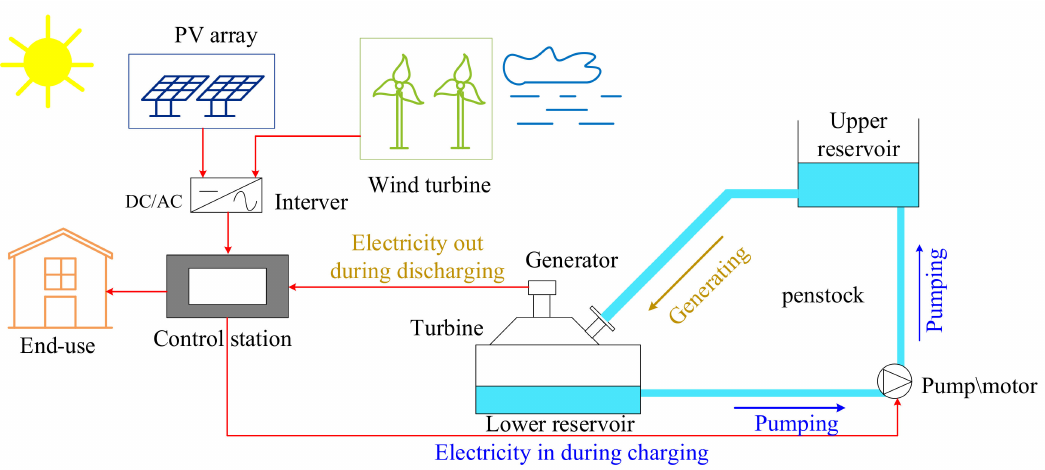
Figure 1. A hybrid solar-wind system with pumped storage